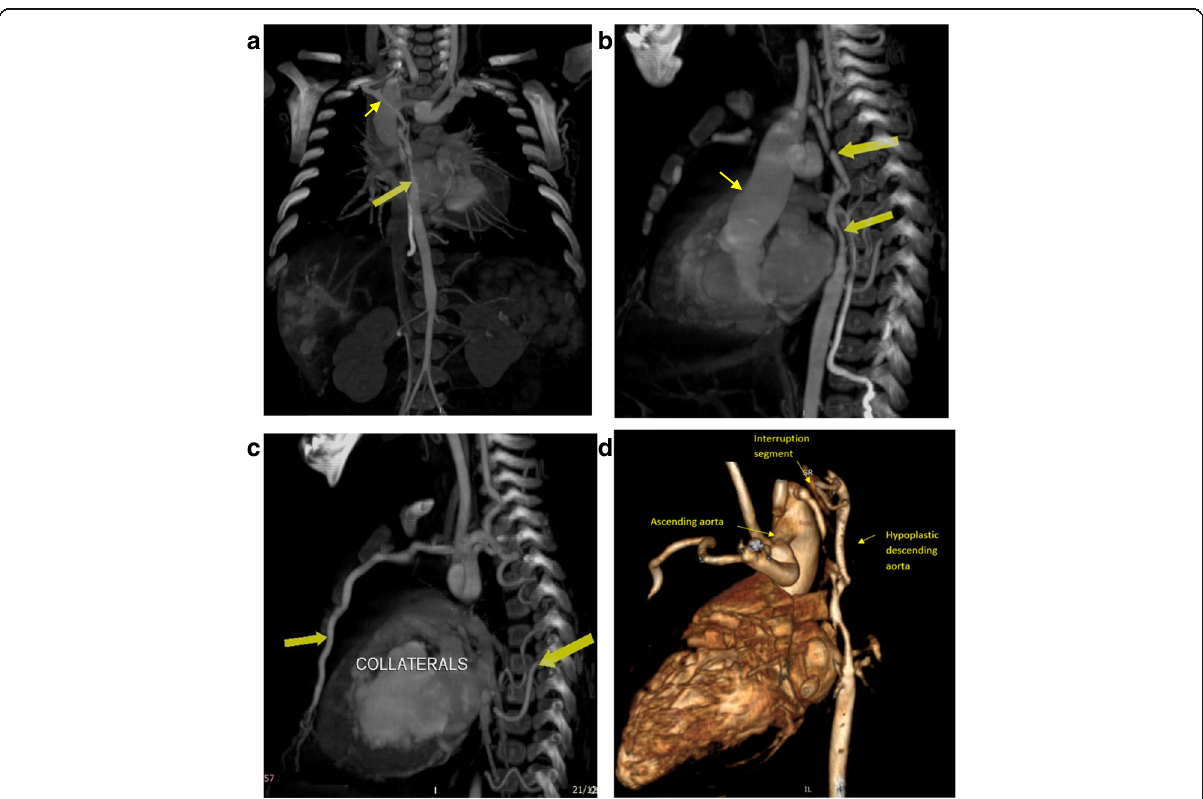
Fig. 1 a MDCT, multi-planar reconstruction (MPR) image with maximal intensity projection (MIP) showing a long segment of descending aorta hypoplasia distal to the interruption (large yellow arrow), small right subclavian artery ( small yellow arrow) coronal view. b MDCT, multi-planar reconstruction (MPR) image with maximal intensity projection (MIP) showing ascending aorta (small yellow arrow), and the long segment of descending aorta hypoplasia distal to the interruption (large yellow arrow), sagittal view. c MDCT, multi-planar reconstruction (MPR) image with maximal intensity projection (MIP) showing the anterior and posterior dilated collaterals (large yellow arrows), sagittal view. d 3D MDCT volume rendering image shows the interruption segment and long segment of aortic